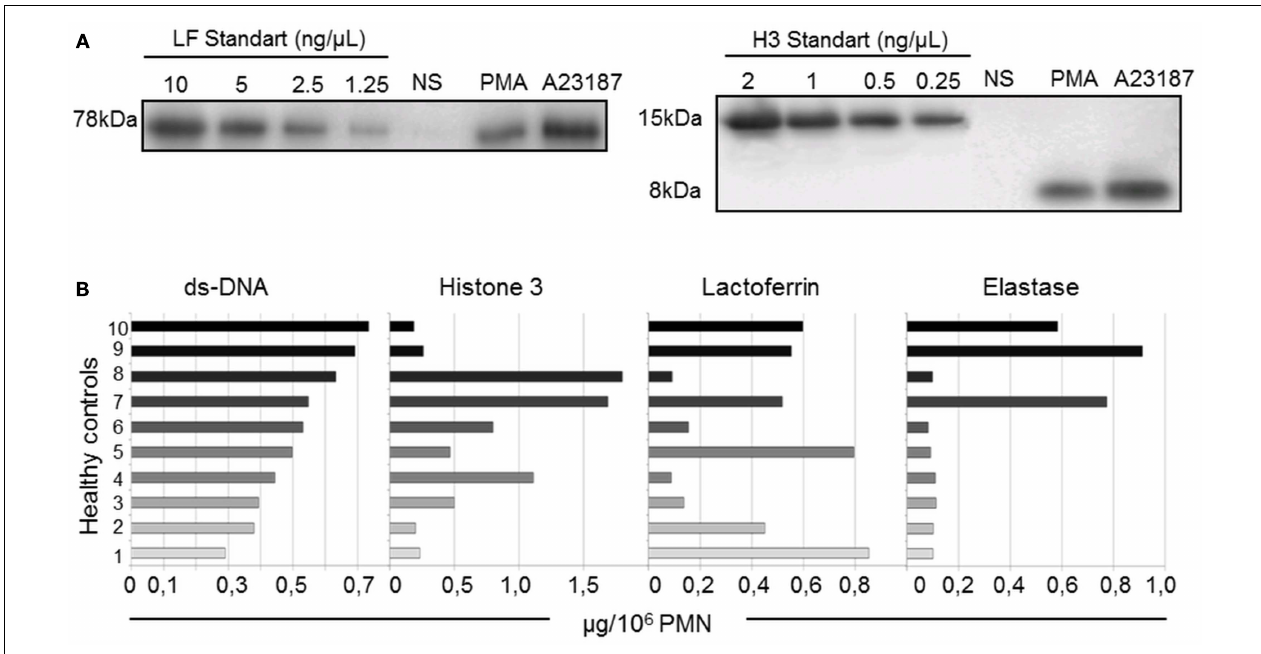
supernatants from one healthy control.The bands were quantified by densitometry and plotted against the standard curve. (B) dsDNA, H3, LF, and ELA concentrations of A23187-NET samples from 10 healthy donors. Results are expressed in µ g/10 6